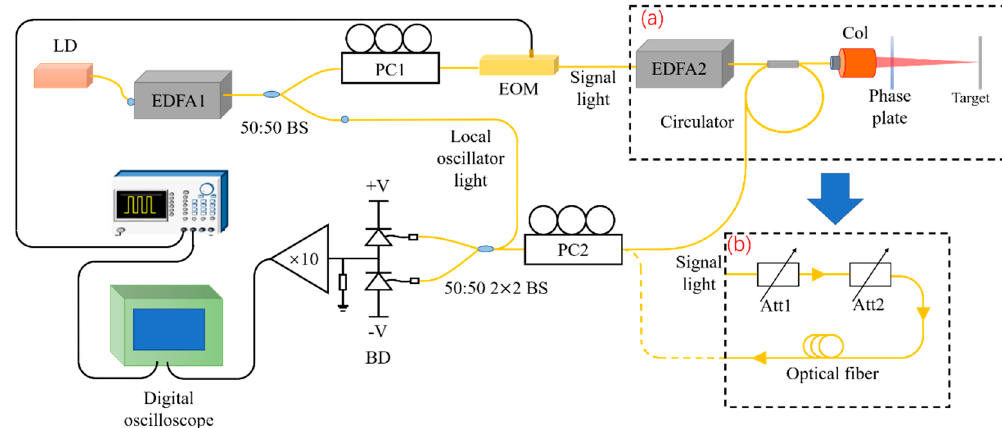
Figure 2. Experimental setup with ( a ) distance measurement system and ( b ) performance test system. LD: Laser diode; EDFA: erbium-doped fiber amplifier; BS: beam splitter; PC: polarization controller; EOM: electrooptic modulator; Col: collimator; BD: balance detector; Att: adjustable attenuator.